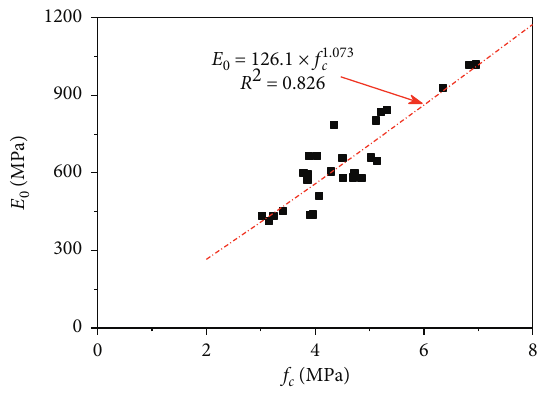
Figure 16: Relation between E